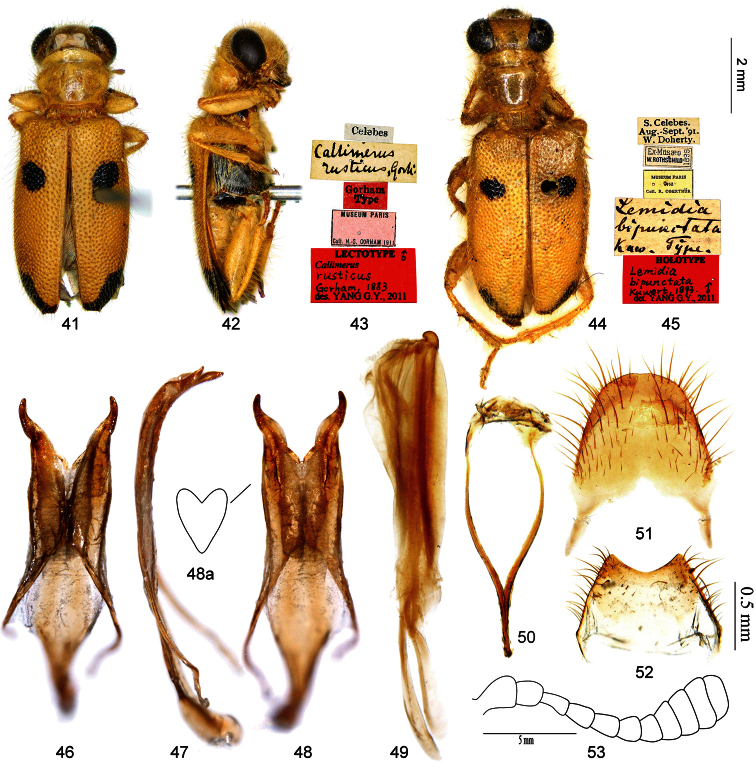
Callimerus rusticus Gorham, 1883. 41–43 Lectotype of Callimerus rusticus Gorham, 1883 (41 dorsal view 42 lateral view 43 labels) 44–45 Holotype of Lemidia bipunctatus Kuwert, 1893 (44 dorsal view 45 labels) 46–52 male terminalia, specimen from Celebes 46–48 tegmen (46 dorsal view 47 lateral view 48 ventral view 48a outline of ventral membranous region) 49 phallus 50 spicular fork 51 tergite VIII 52 sternite VIII 53 antennae, specimen from Celebes.